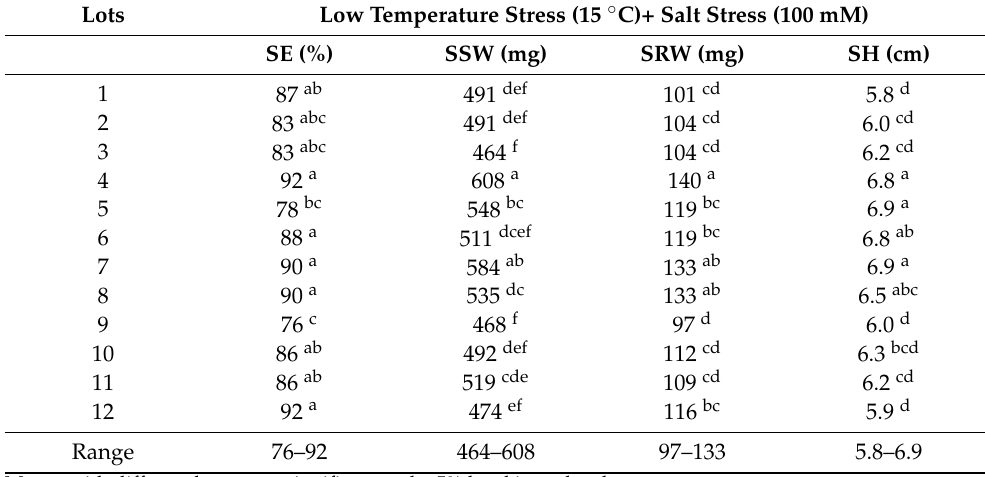
Table 4. Variation in seedling emergence (SE, %), seedling shoot weight (SSW, mg), seedling root weight (SRW, mg) and seedling height (SH, cm) at low temperature and salt stress combination. Means with different letters are significant at the 5% level in each column.